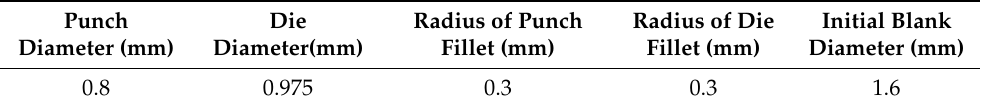
Table 2. Parameters of the die set and blank.